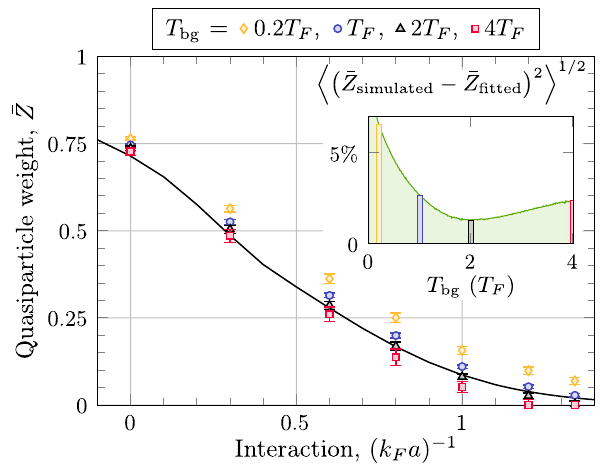
FIG. 12. Fitting simulated background Raman spectra with fixed effective temperature T . The black line denotes the bg homogeneous many-body quasiparticle weight computed for T ¼ 0 . 2 T x ¼ 0 . 15 . Error bars mark the fitted residue using F , an effective temperature of 0 . 2 T F (yellow diamonds), T F (blue circles), 2 T F (black triangles), and 4 T F (red squares). Inset: root- mean-square deviation of the extracted residue from the com- puted one, exhibiting a minimal deviation at approximately 2 T F , the value we use for fitting the experimental